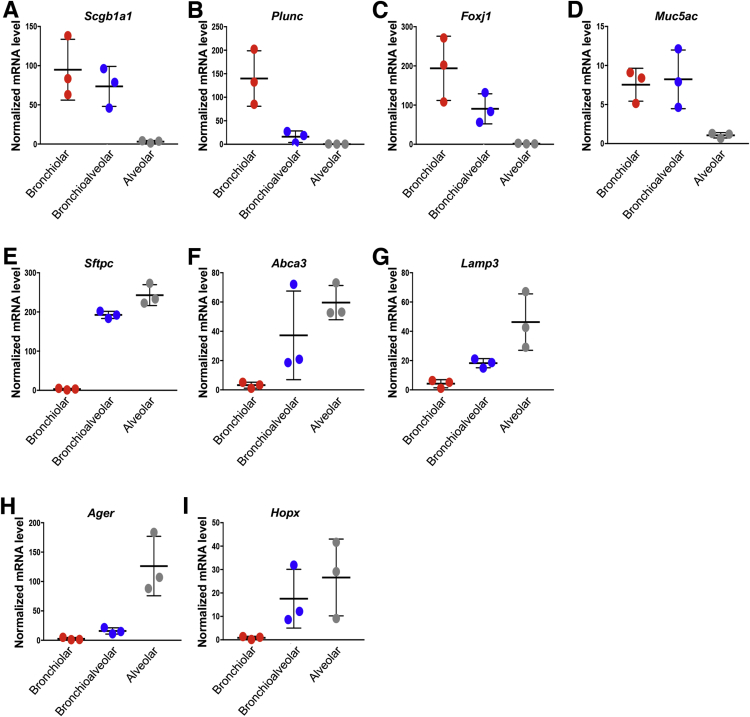
Lgr6+ Cells Support Multi-lineage Differentiation of Scgb1a1+ Cells, Related to Figure 5qPCR analysis for expression levels of airway lineage markers (A-D) and alveolar lineage markers (E-I) on individual organoids of different typologies that were derived from lineage-labeled Scgb1a1+ cells co-cultured with Lgr6+ cells: Scgb1a1, Plunc for club cells; Foxj1 for ciliated cells; Muc5ac for goblet cells; Sftpc, Abca3, Lamp3 for AT2 cells; Ager, Hopx for AT1 cells. Each graph shows the expression levels of each gene per typology of organoid (n = 3 organoid per typology). Normalized to Gapdh.